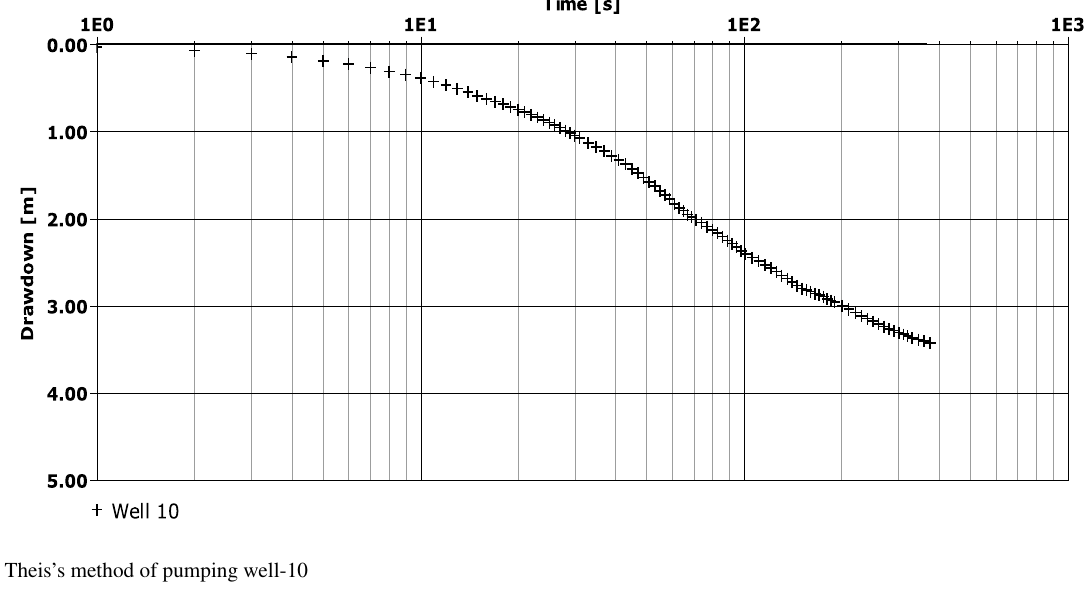
Fig. 27 Theis’s method of pumping well-10